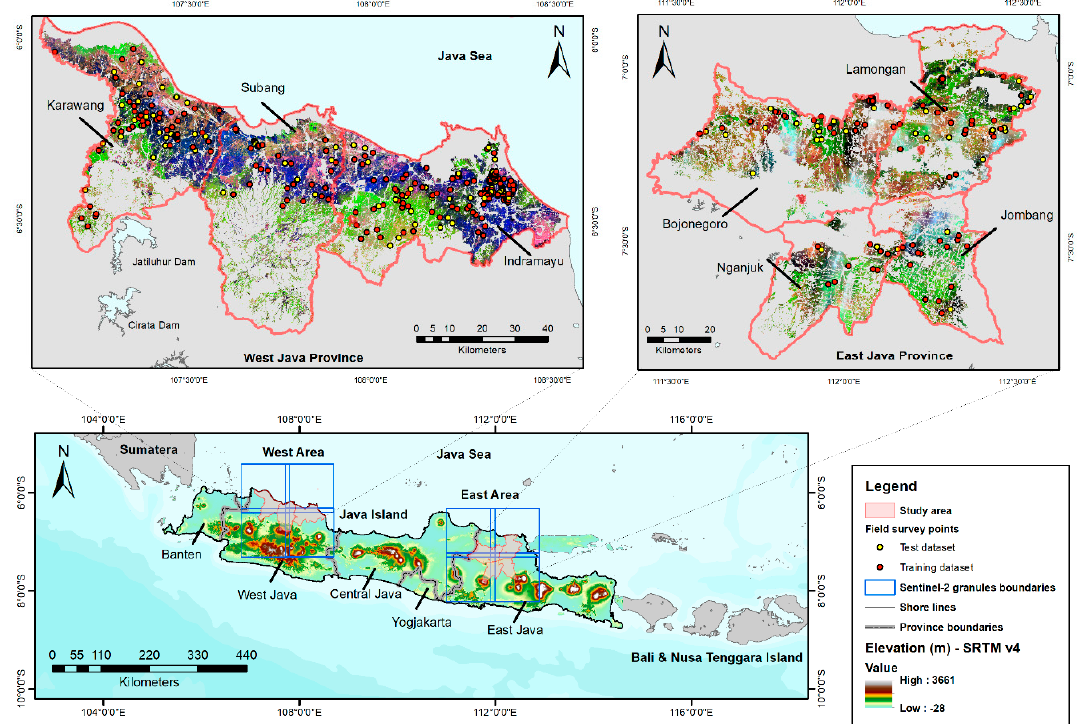
Figure 2. Map of the study area for West Area and East Area and overlay with the false colour (NIR / SWIR / Green) of Sentinel-2 image, which has been masked to show only the paddy rice fields for the West Area on 11 and 14 June 2018 and for the East Area on 13 June 2018.